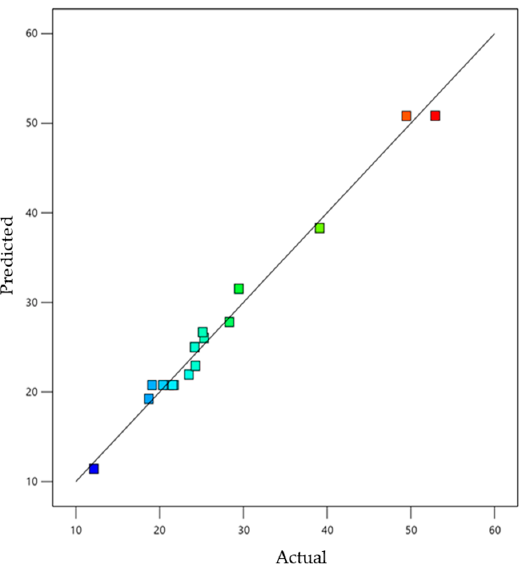
Figure 2. Linear correlation plot between actual and predicted values for Encapsulation Efficiency response (Y 1 ).